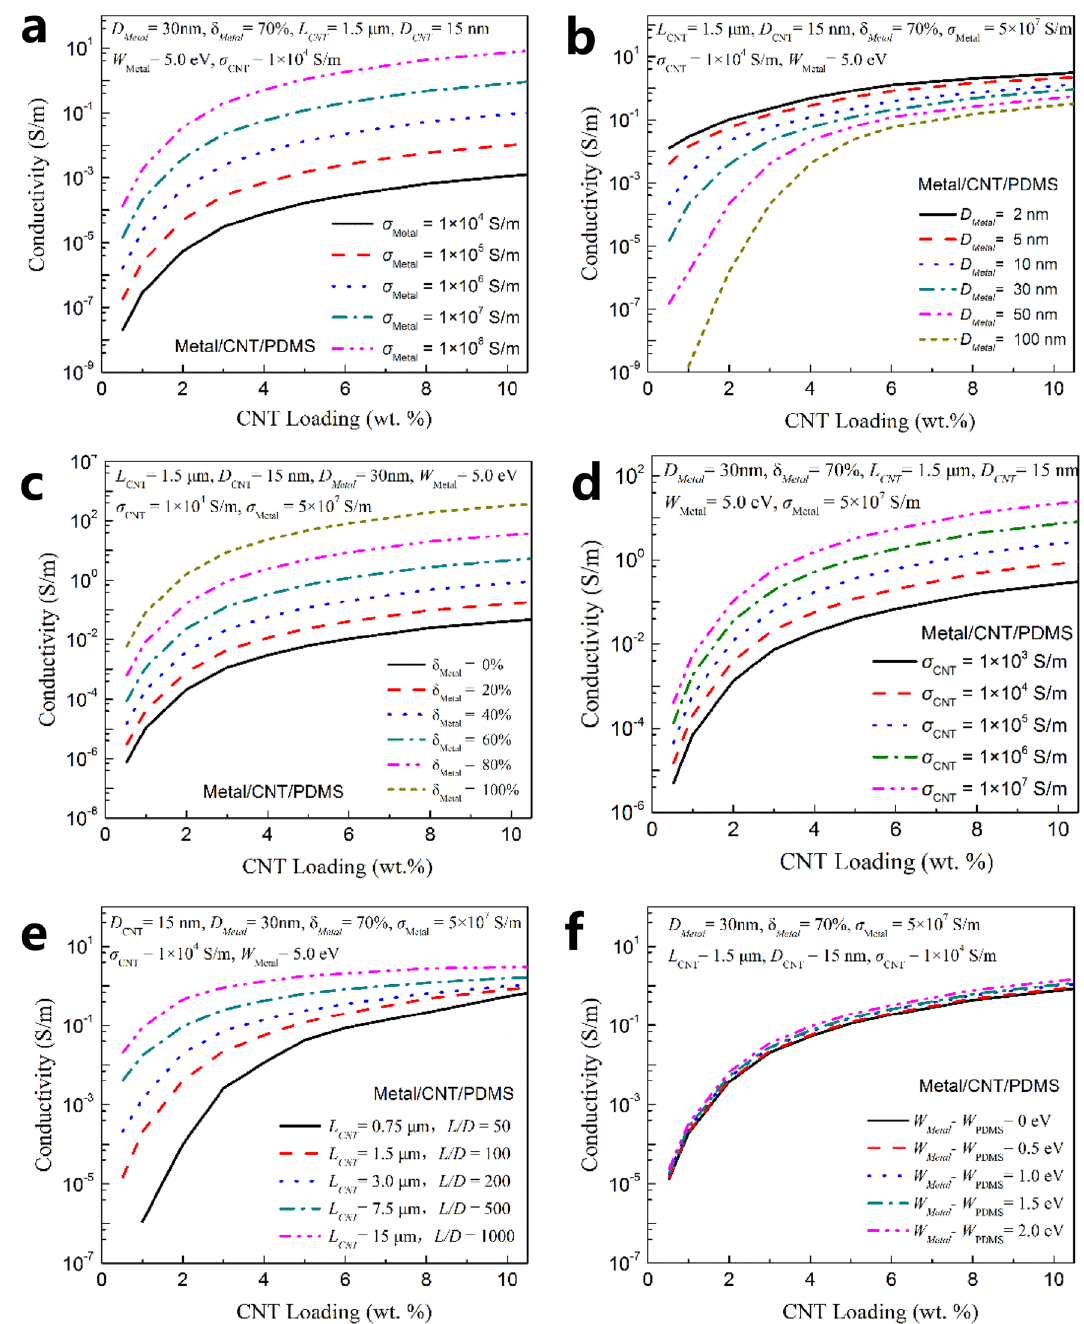
Figure 6. Calculation and simulation results of conductivity on Metal/CNT/PDMS films with various ( a ) σ Metal , ( b ) D Metal , ( c ) δ Metal , ( d ) σ CNT , ( e ) L CNT , ( f ) W Metal -W PDMS